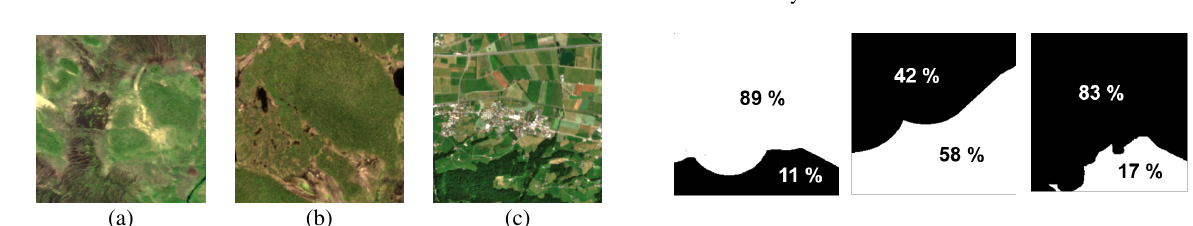
Figure 2. Flowchart of the dataset preparation in Google Earth Engine. A, B, and C refer to training, validation, and test sets, respectively. The abbreviations are defined as follows: WDPA – World Database of Protected Areas, S2 SR/S2L2A – Sentinel-2 Level 2A imagery, QA60 – 60m resolution quality band of Sentinel-2, ROI – region of interest, CSV – comma-separated value file, UTM – Universal Transverse Mercator coordinate system.